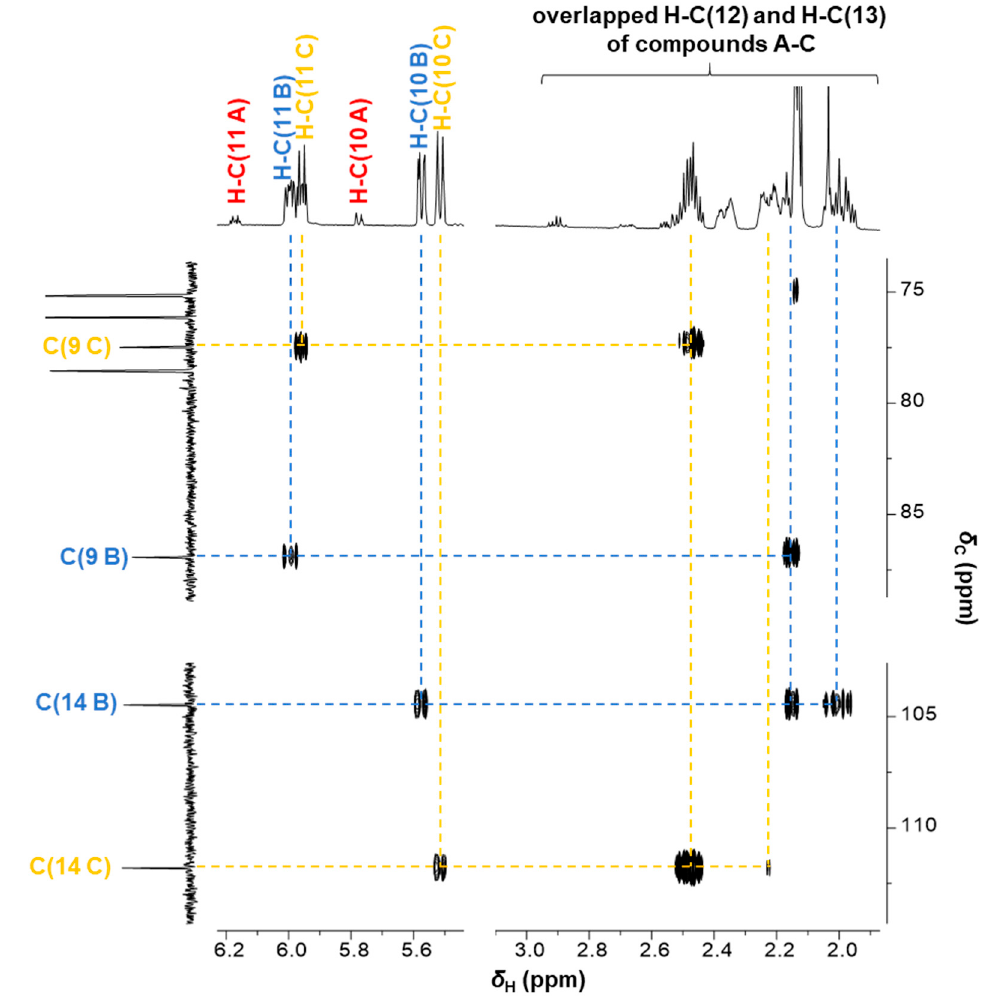
Figure 7. Excerpt of the heteronuclear multiple bond correlation (HMBC) experiment of fraction F7-4, indicating the correlations of the protons H-C(10) and H-C(13 α and 13 β ) with the carbon C(14) of the compounds B (blue) and C (yellow), which are shifted to a lower frequency in comparison to carbon C(14 A), as part of the 2 ′ - O -acetylsalicortin structure, and resonating at 207.4 ppm (not shown).